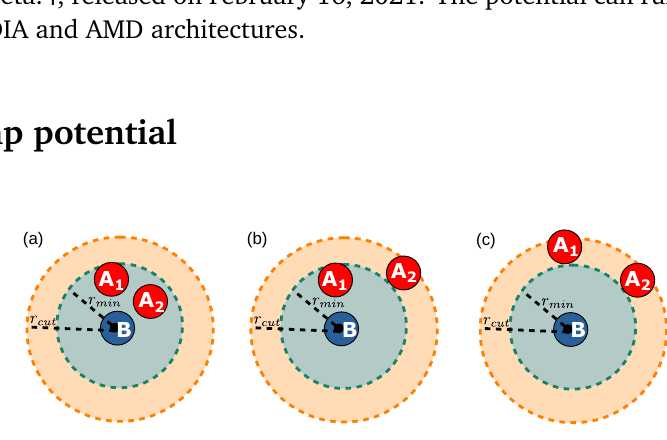
from B, so it follows from eqn (1) that the three m causing the other to feel m and A are beyond r so they both m 1 2